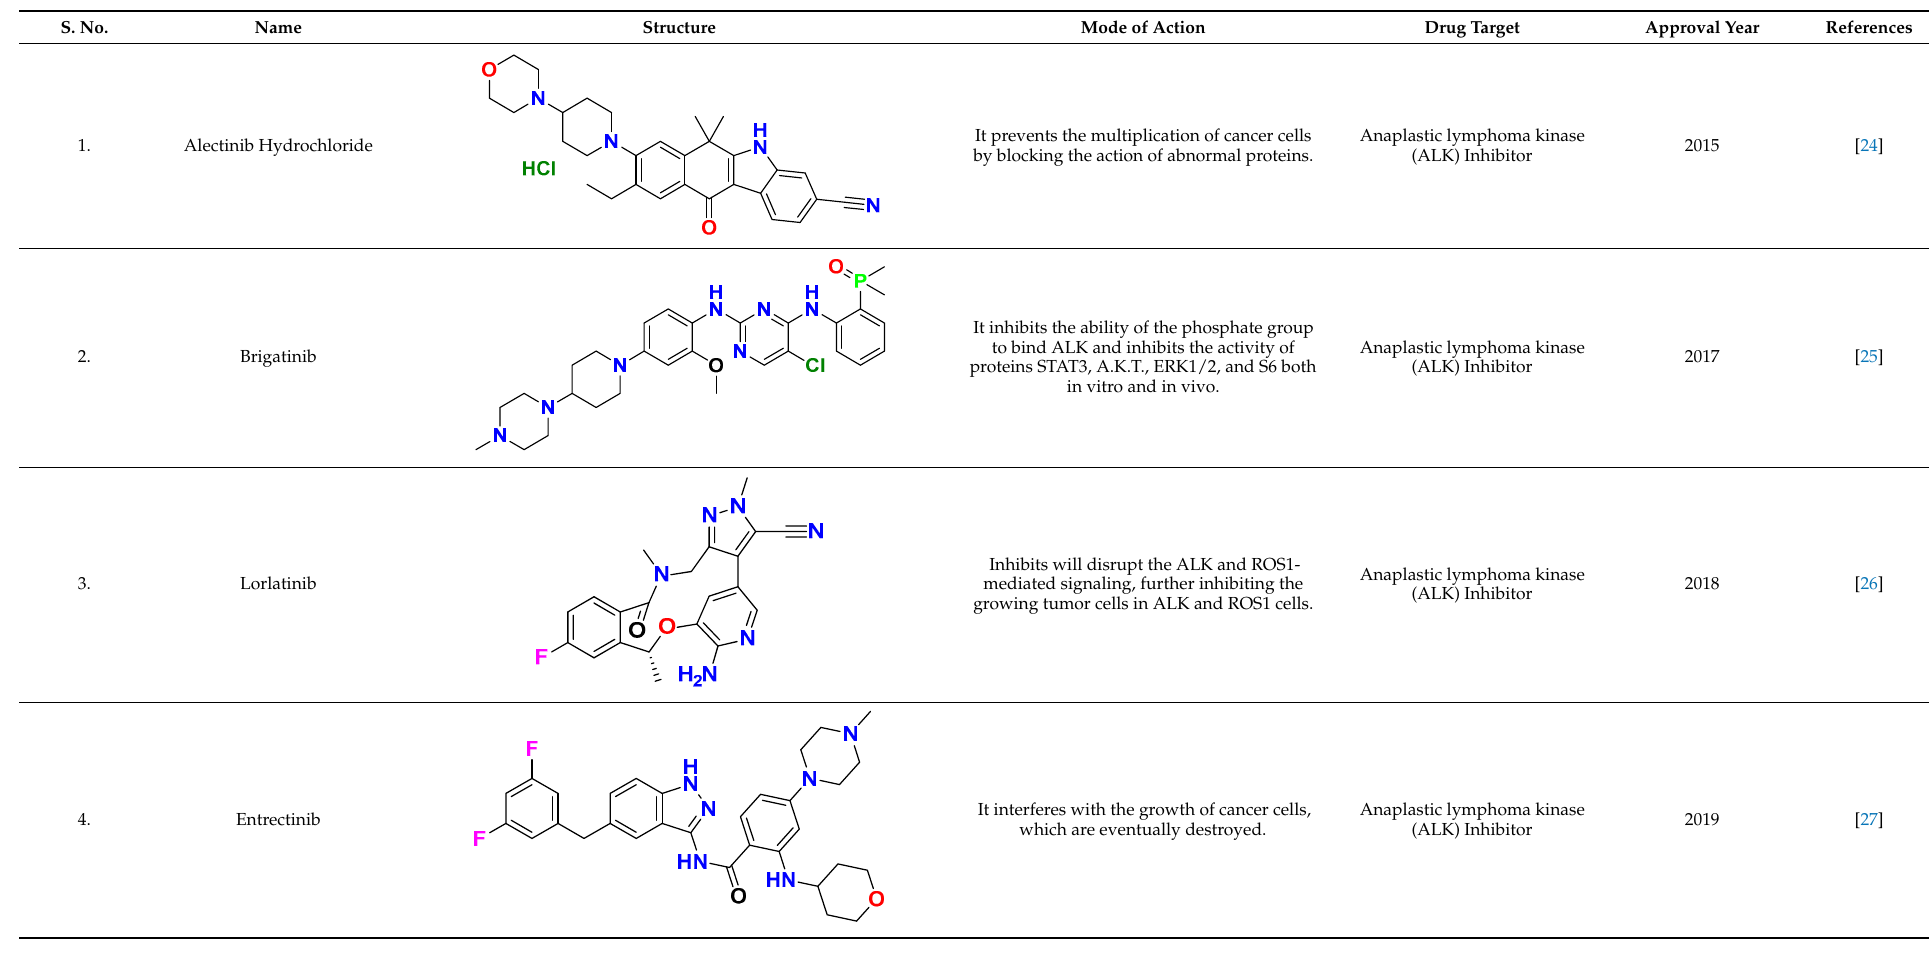
Table 1. Nitrogen-containing FDA-approved drugs.